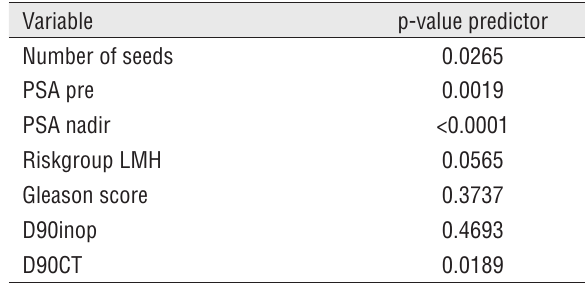
Table 2 - Logistic regression with disease free survival after 5 years as outcome variable. The number of implanted seeds, PSA level pre-brachytherapy, PSA nadir and estimated D90 level on CT scan were significant predictors.